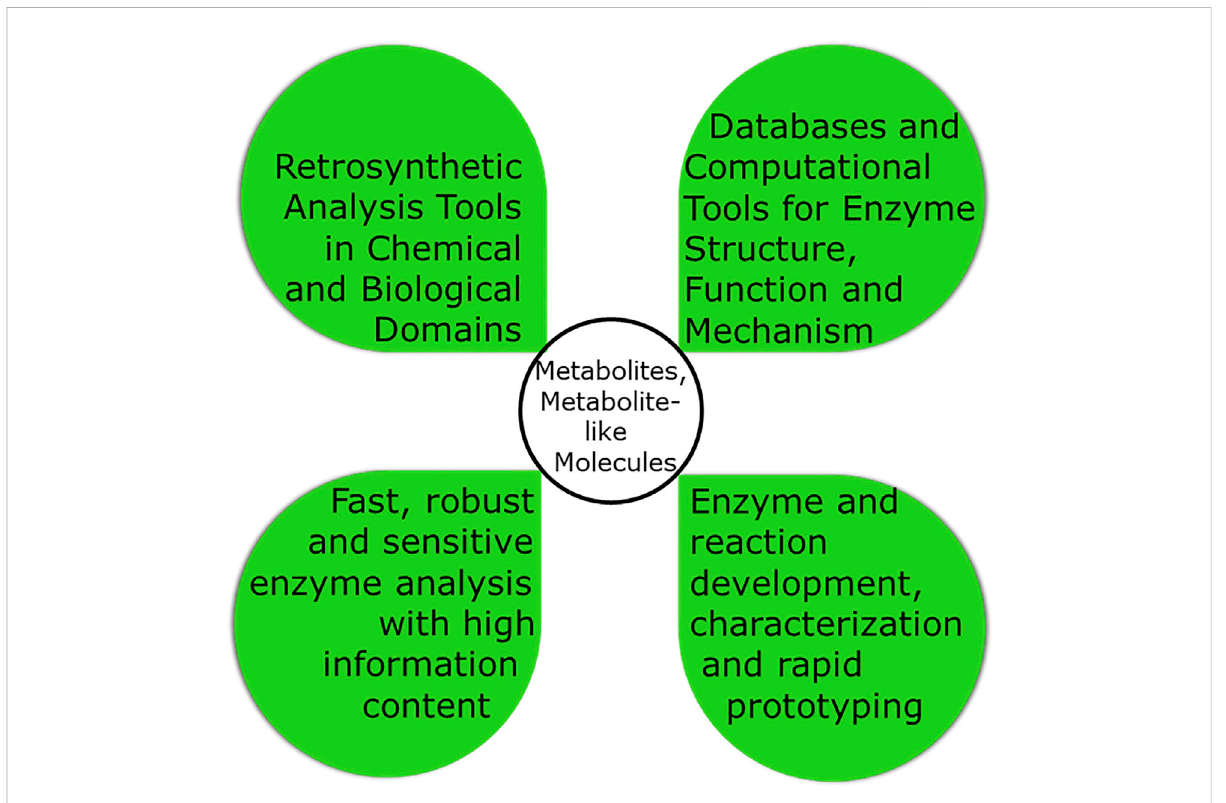
FIGURE 4 The four key aspects for the design of a biocatalytic process in target-oriented. synthesis of metabolites and metabolite-like